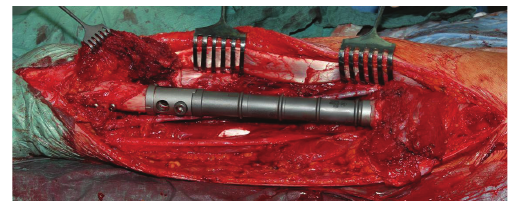
Figure 2: Left thigh after wide tumour resection and implantation of a Mutars femur diaphysis implant.